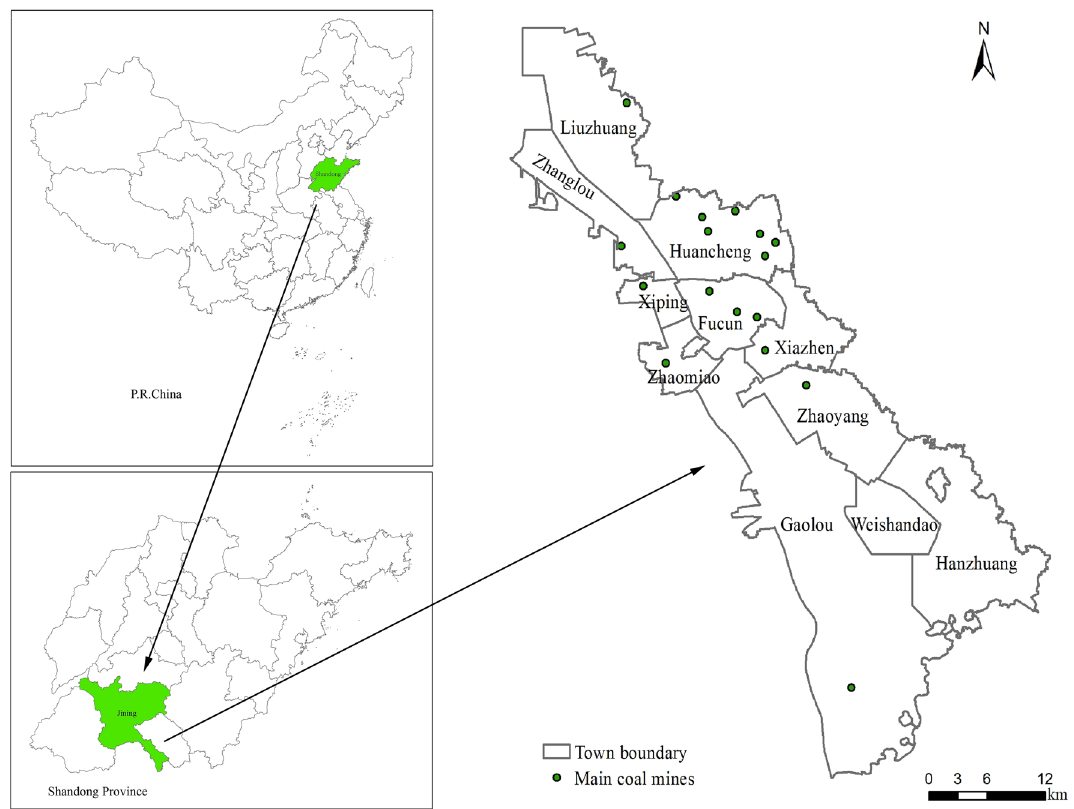
Figure 1. Geographical location and mining area distribution in the research area. Maps were generated using ArcGIS 10.1 for Desktop (http:// www. esri. com/ softw are/ arcgis/ arcgis- for- deskt